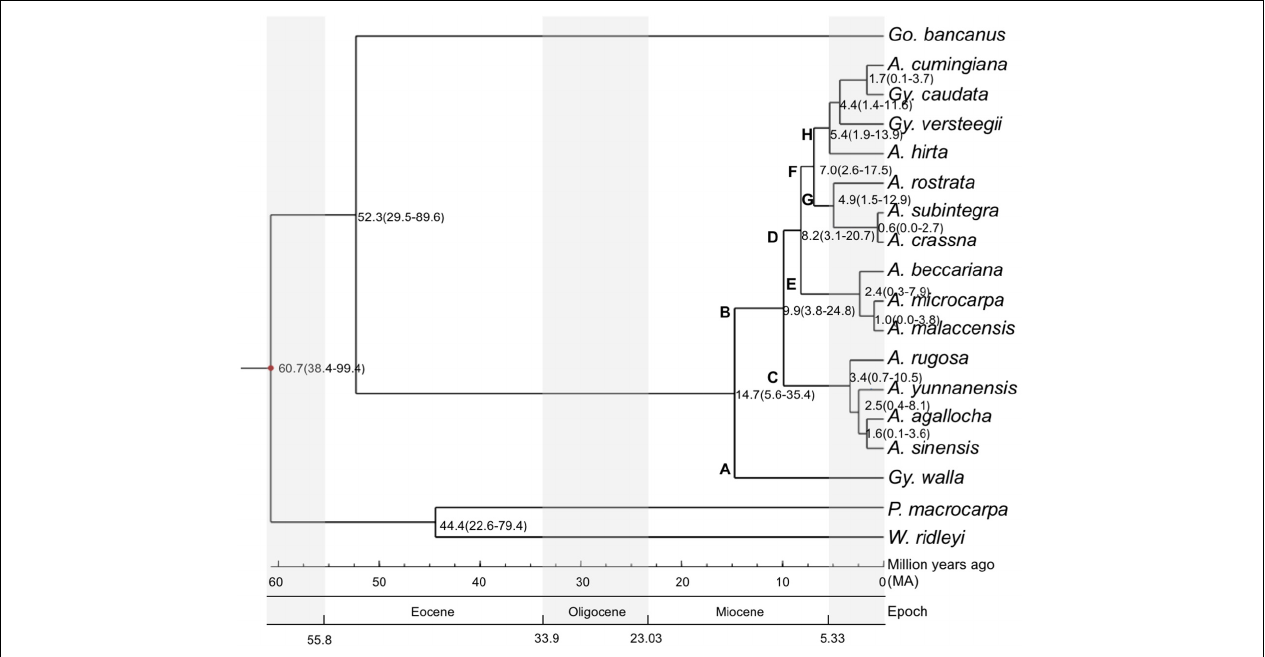
FIGURE 3 | Divergence time estimation for species in the tribe Aquilarieae. Bayesian consensus tree inferred from the combined sequences of chloroplast non-coding genes mat K and rbc L, chloroplast gene intron trn L, and chloroplast intergenic spacer region trn L- trn F and psb C- trn S from 15 species in the Aquilarieae tribe. Gonystylus bancanus , Phaleria macrocarpa , and Wikstroemia ridleyi were used as outgroups. The red dot on the node represent estimated divergence time used to calibrate the analysis. The scales below the phylogenetic tree indicate the estimated divergence time in million years ago (Ma), which happened over several epochs. (A, Aquilaria ; Gy, Gyrinops ; Go, Gonystylus ; P, Phaleria ; W, Wikstroemia